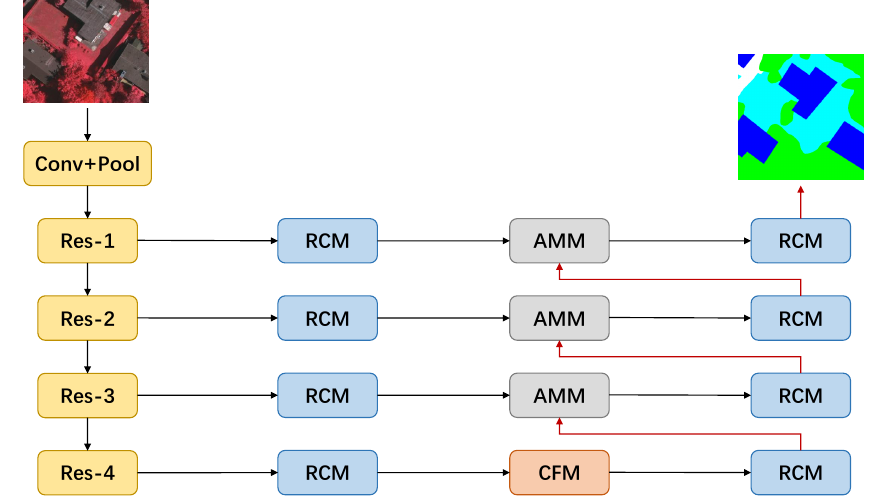
Figure 1. An overview of our proposed Context Aggregation Network. Red lines represent bilinear upsample operation. CFM: Context Fuse Module, AMM: Attention Mix Module, RCM: Residual Convolutional Module.